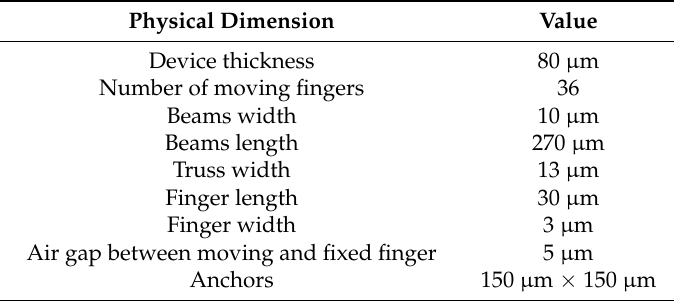
Table 3. Physical dimensions of the design B MEMS